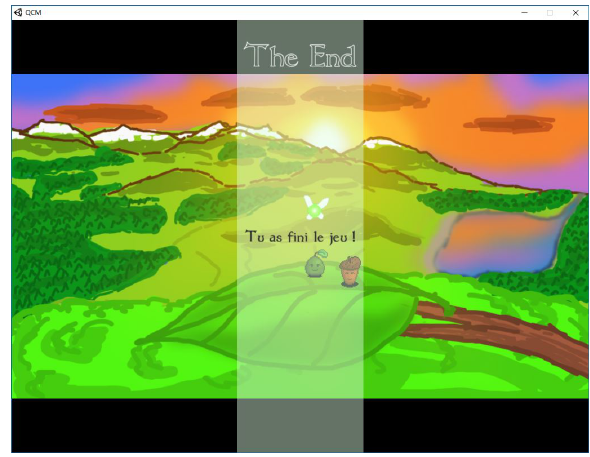
Figure 5. Experimented games in classroom: screenshot of the narrative game.